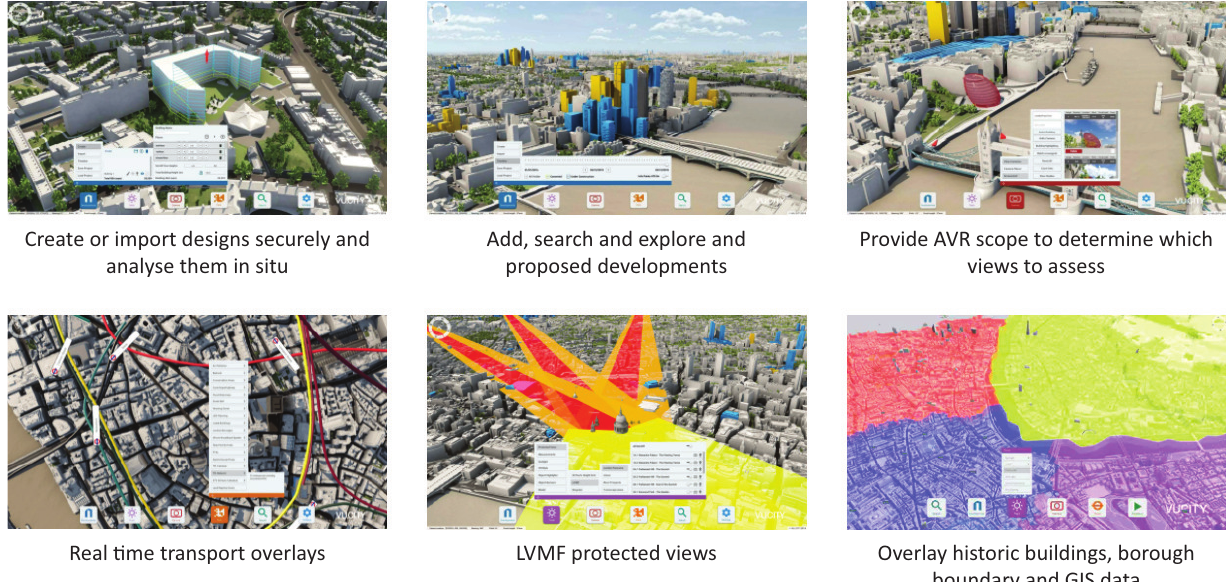
Figure 4. VU.CITY 3D London model with example applications and data overlays. Note: AVR—Acurate visual representa‐ tion; LVMF—Landscape visual impact